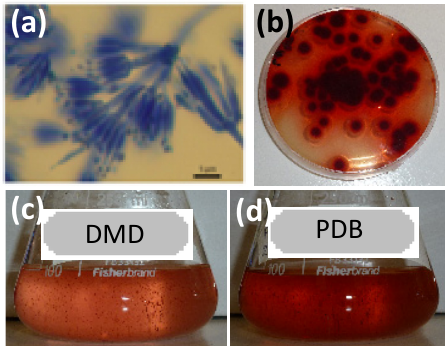
Figure 1. Morphological features of the marine-derived Talaromyces sp. 30570 strain: ( a ) Conidiophores produced on Potato Dextrose Agar (PDA) media, stained with lactophenol blue (scale bar 5 µ m); ( b ) Reverse face of fungus grown on PDA; ( c ) Red pigment production in Defined Minimal Dextrose (DMD) medium incubated for 7 days at 24 °C; ( d ) Red pigment production in Potato Dextrose Broth (PDB) medium incubated for 7 days at 24 °C.